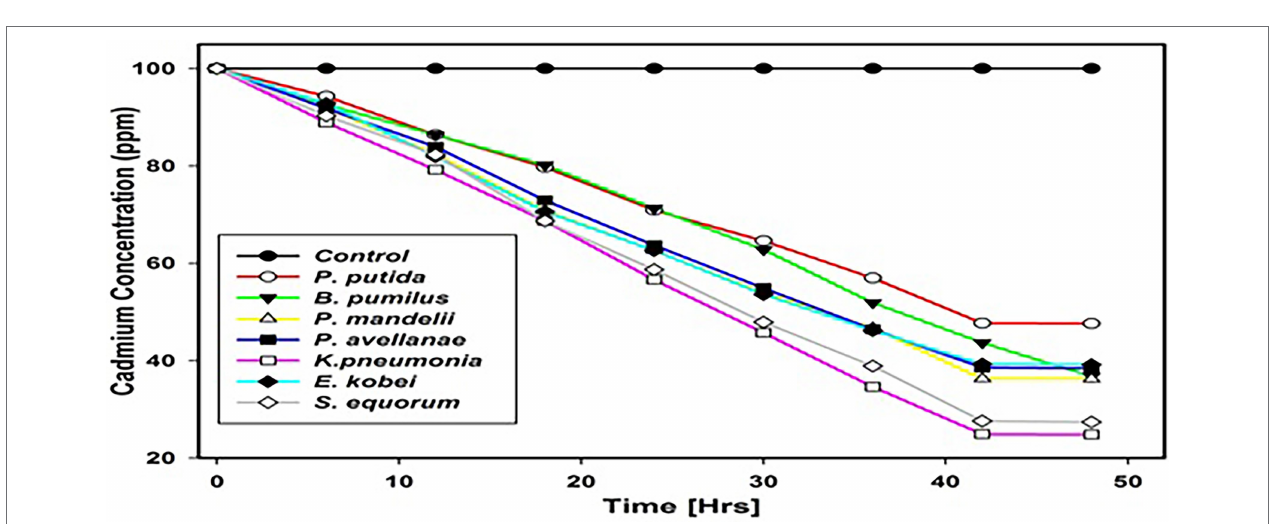
FIGURE 6 | Sequestration potential of cadmium-tolerant metal isolates in ppm.